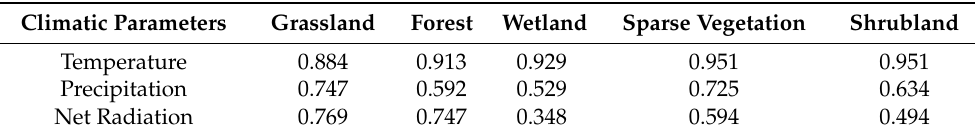
Table 3. Correlation coefficients ( r ) between daily NPP of different vegetation types and climatic parameters in the growing season during the study